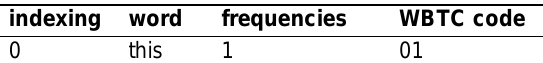
Table 8: Word-frequency table for length four